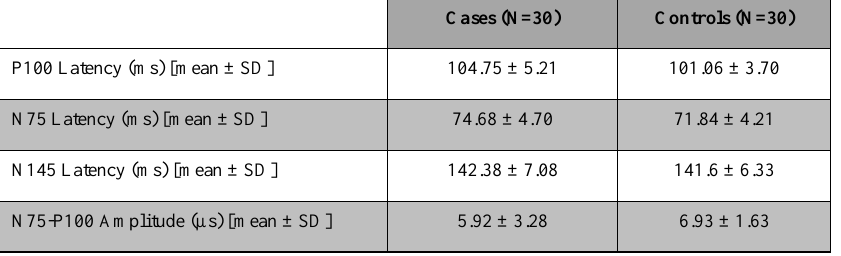
Table 9. Average of Right eye and Left eye values of VEP parameters in cases and controls.